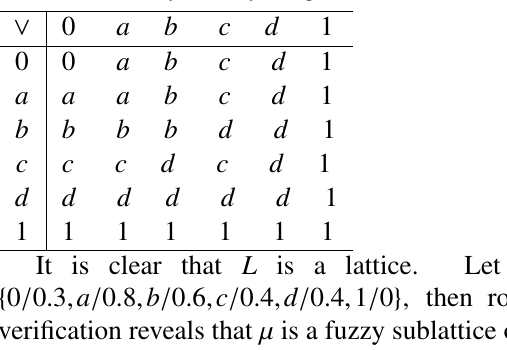
Table 2. the definition of the operator ∨ on